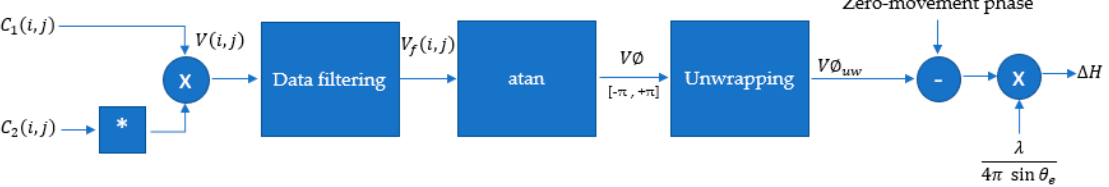
Figure 4. Block diagram for DInSAR processing.